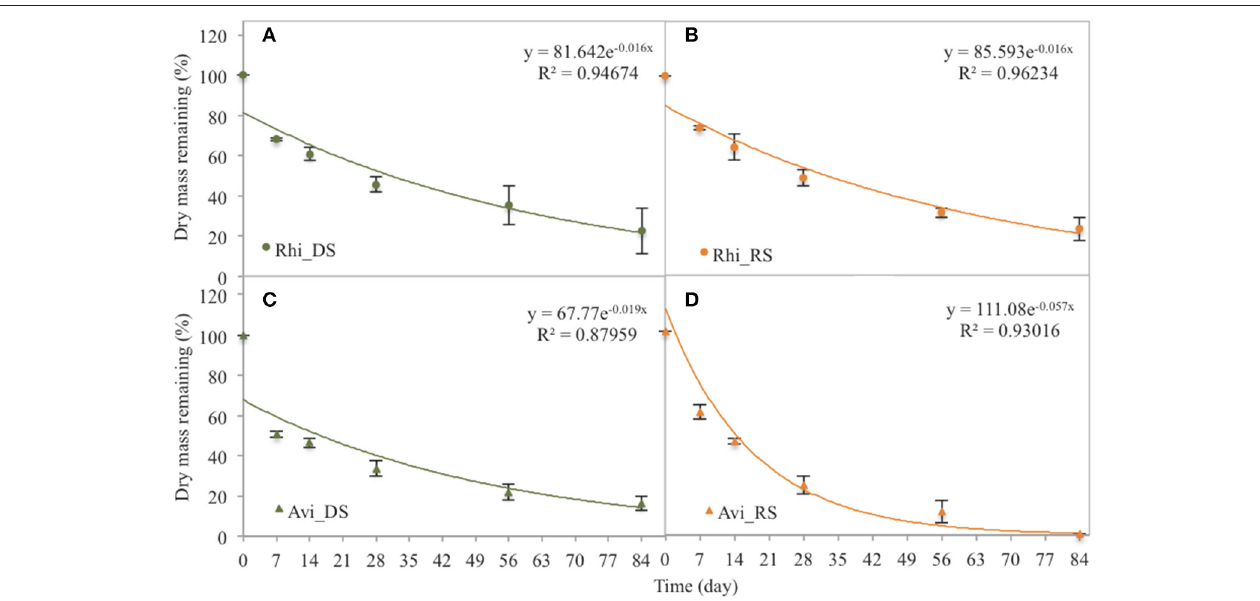
FIGURE 3 | Dry mass remaining of Rhizophora (Rhi) and Avicennia (Avi) leaves during the 84 days of the decomposition experiment. DS is the dry season, and RS is the rainy season. (A) Rhizophora dry season. (B) Rhizophora rainy season. (C) Avicennia dry season. (D) Avicennia rainy season.